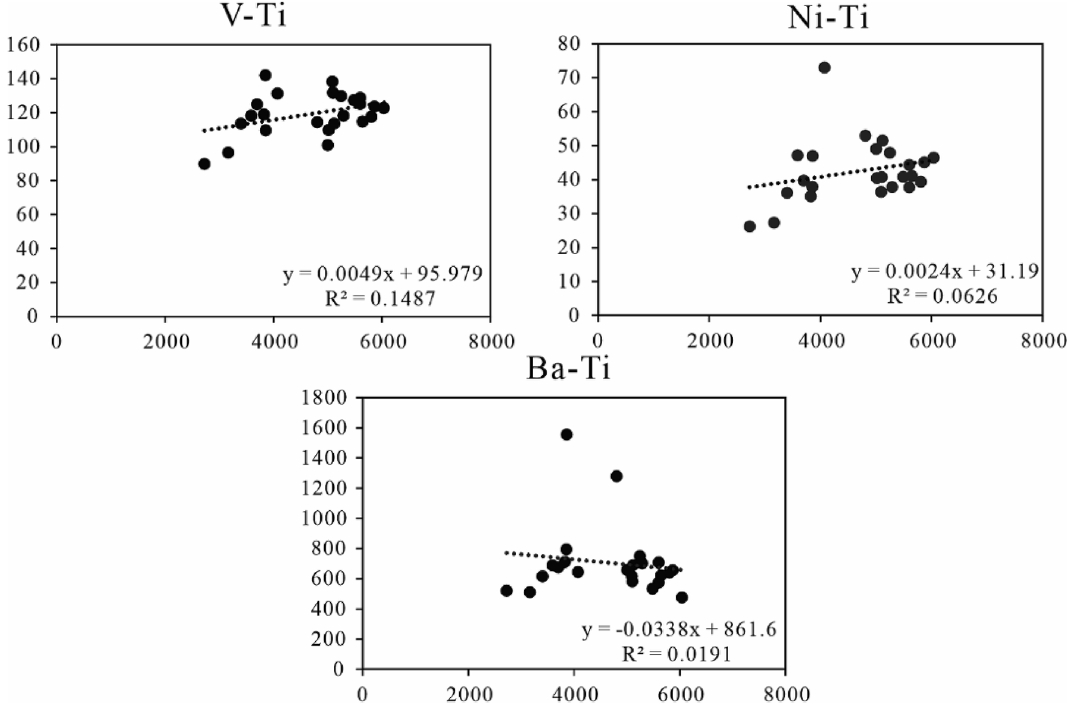
Figure 6. The crossplot of V, Ni, Ba, versus Ti to evaluate the impact of terrigenous debris influence.